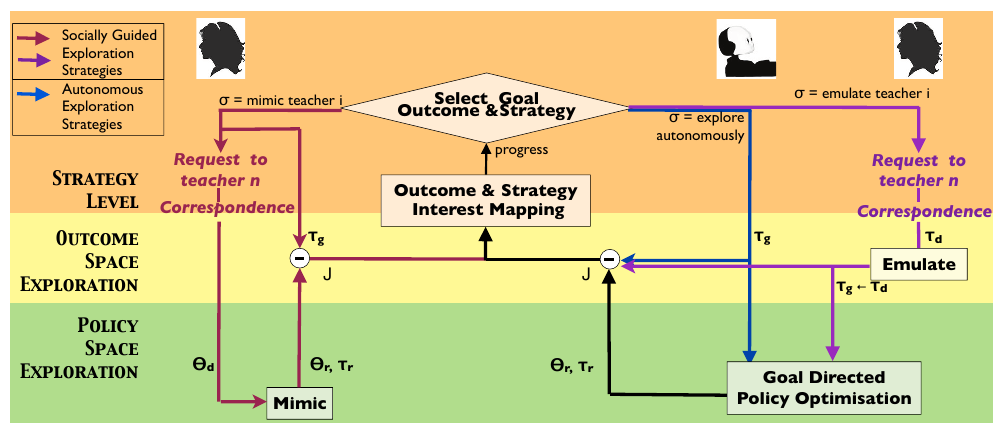
Figure 3. Time flow chart of SGIM-ACTS, which combines Intrinsic Motivation and Mimicking and Emulation into 3 layers that pertain to the strategy, the outcome space and the policy space exploration respectively. achieves an outcome τ